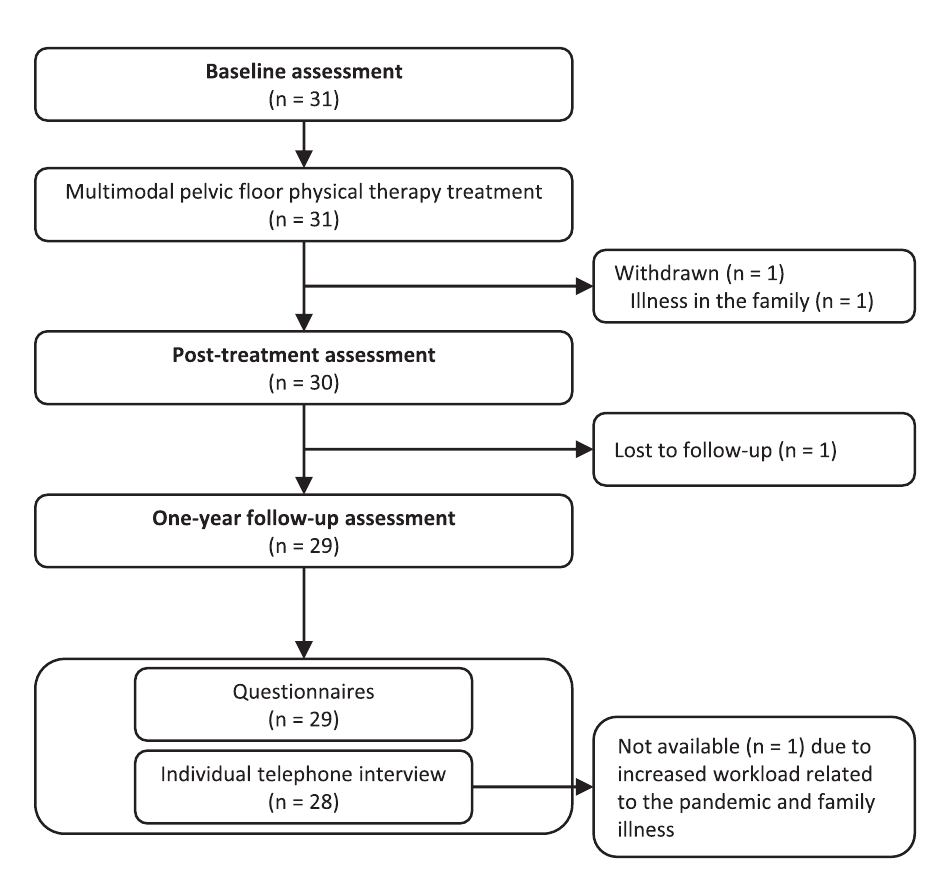
Fig 1. Flow of participants through the